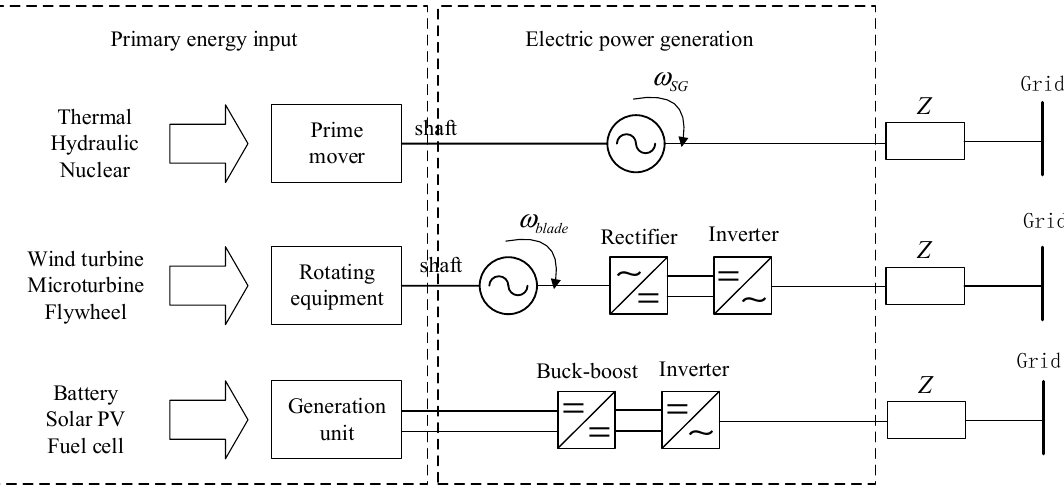
Figure 4. Comparison between SGs and IBG.